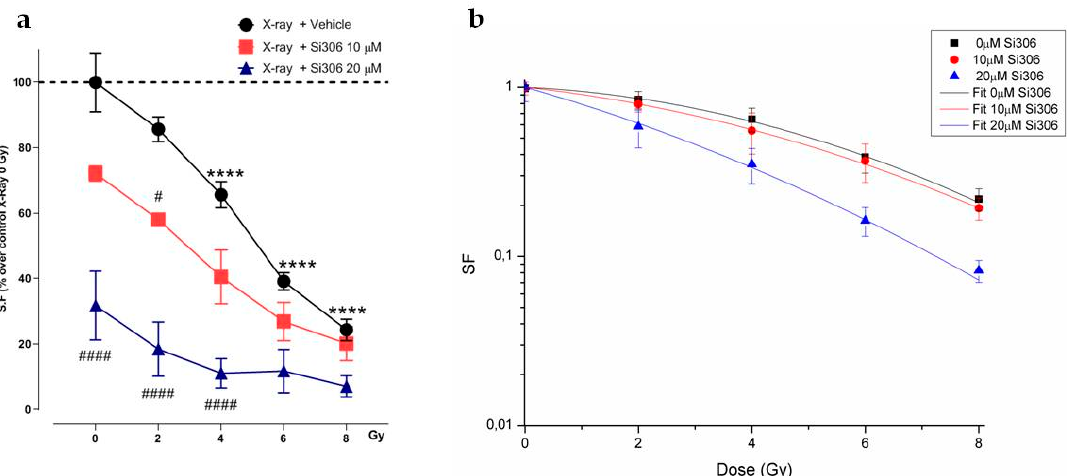
Figure 4. SF of irradiated cells with Si306 exposure in hypoxia. ( a ) Mean ± SEM, three independent experiments; **** p -value < 0.0001 versus 0 Gy in normoxia; # p -value < 0.05 and #### p -value < 0.0001 versus X-rays + vehicle at the same dose (F Si306conc . = 34.09, p -value < 0.0001; F Gy = 77.95, p -value < 0.0001; F Si306conc. x Gy = 3.929, p -value = 0.0012. Two-way ANOVA with Holm–Š í d á k post-hoc test). ( b ) Linear-quadratic adjustment of the data of U251 cell survival curves treated with X-rays only and combined with Si306 in hypoxia.